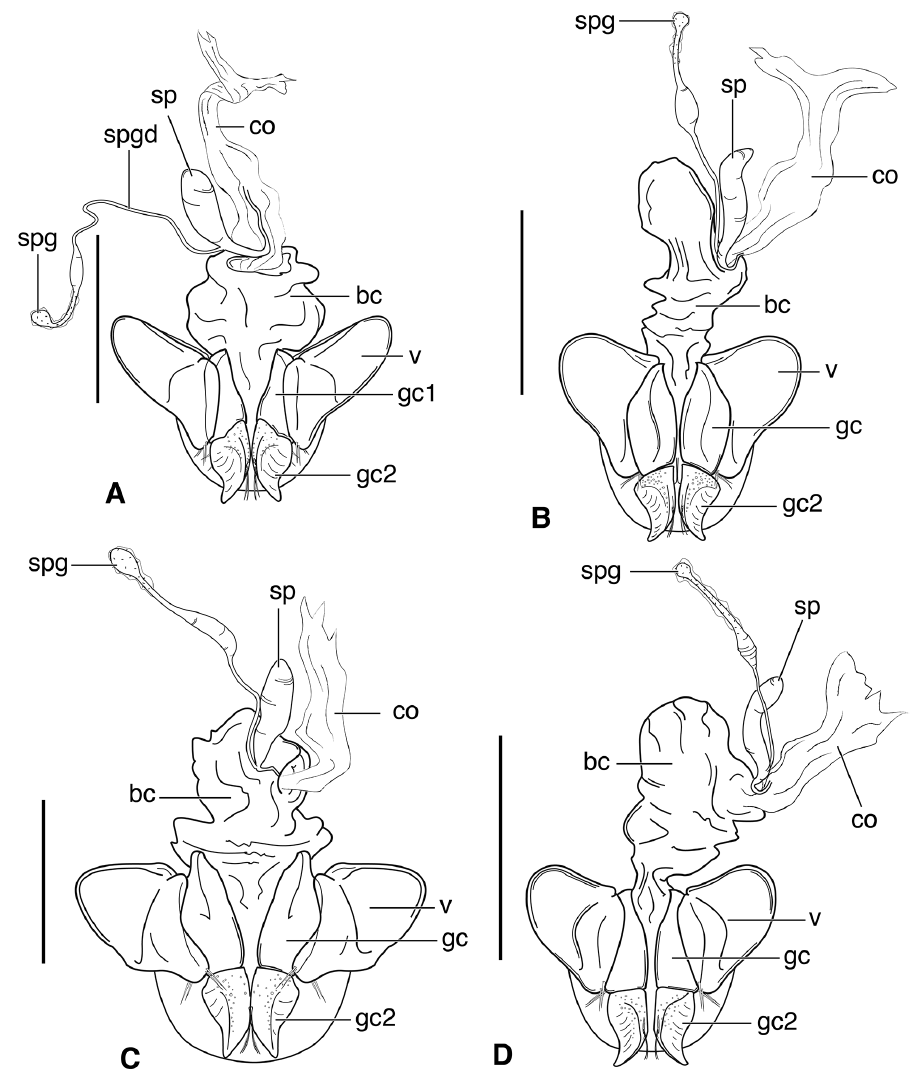
Figure 69. Line drawings of female reproductive tract of Discoderus species, ventral aspect. A D. beauvoisii (Dejean) B D. cinctus (Putzeys) C D. cyaneopacus (Darlington) D D. thoracicus (Putzeys). Legend: bc bursa copulatrix co common oviduct gc1 gonocoxite 1 gc2 gonocoxite 2 sp spermatheca spg spermathecal gland spgd spermathecal gland duct v valvifer. Scale bars 1 mm.